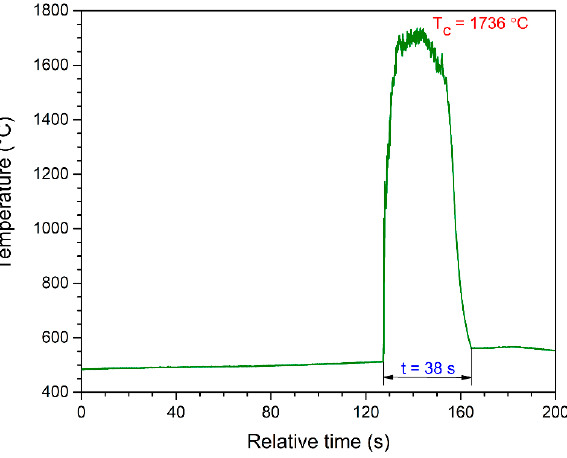
Figure 1. The temperature evolution during the combustion synthesis of sample F.